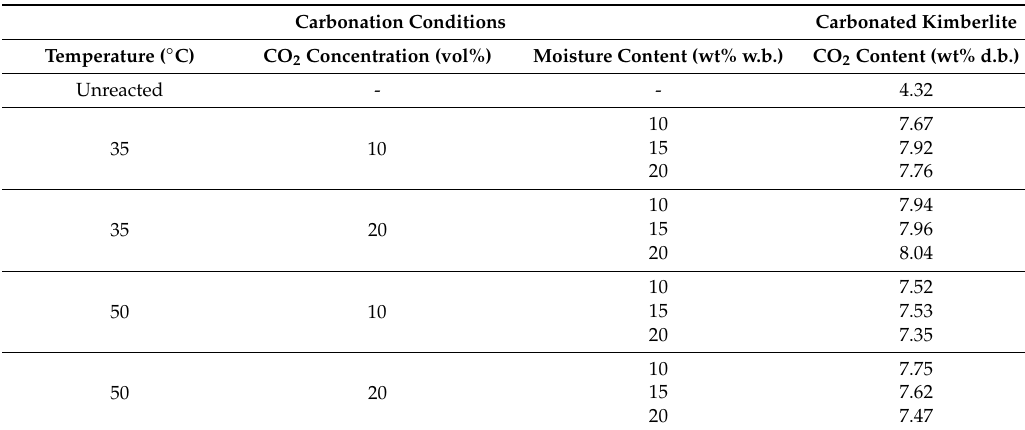
The amount of CO 2 released during furnace test from the unreacted and thin-film carbonated